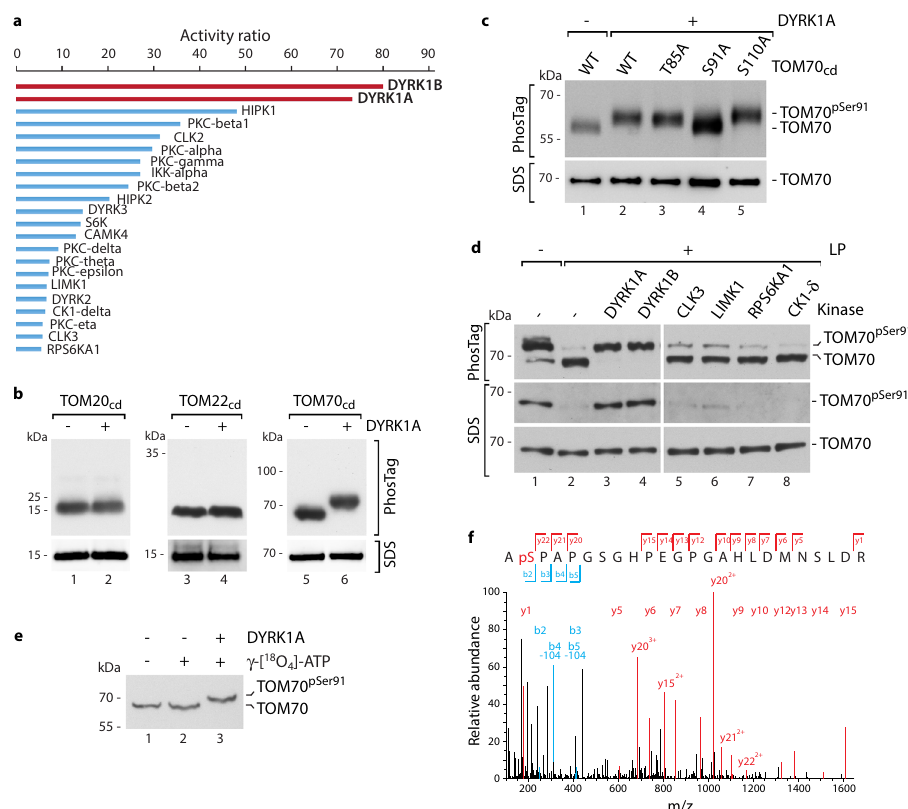
Fig. 1 Identi fi cation of DYRK1A as kinase of the mitochondrial import receptor TOM70. a Results of KinaseFinder assay (ProQinase TM ) for human TOM70 cd tested for 339 different protein kinases. Shown are activity ratios of 33 P-ATP-radiometric fi lter binding assays. b In vitro phosphorylation assay of soluble cytosolic domains (cd) of the human import receptors TOM70, TOM20, and TOM22. Proteins were incubated in the presence or absence of human DYRK1A. Samples were analyzed via Phos-tag electrophoresis, SDS-PAGE and immunoblotting using the respective TOM antibody (Supplementary Table 1). c In vitro kinase assay of indicated TOM70 cd variants in the absence or presence of DYRK1A. Samples were analyzed by Phos-tag gel electrophoresis (upper panel) or standard SDS-PAGE (lower panel) followed by immunoblotting using TOM70 antisera. d Analysis of isolated mitochondria from HEK293T cells incubated in the presence or absence of lambda phosphatase (LP). Where indicated samples were incubated with the respective kinase after LP treatment. Samples were analyzed by Phos-tag gels (upper panel) or standard SDS gels (middle and lower panel). Upper and lower panels show immunoblots stained with TOM70 antibody and middle panel was stained with TOM70 Ser91 phosphospeci fi c antibody. e Isolated mitochondria were incubated with γ -[ 18 O 4 ]-ATP and DYRK1A where indicated. Samples were analyzed via Phos-tag gels and immunoblotting using TOM70 antibody. f MS/MS spectrum from mitochondria incubated with γ -[ 18 O 4 ]-ATP shown in e localizing the DYRK1A-dependent phosphorylation of TOM70 to Ser91. Identi fi ed b- and y-ions are listed in blue and red, respectively. The b2-y22 ion pair localizes the phosphorylation unambiguously to Ser91. The amino acid sequence of the respective tryptic peptide TOM70 90 – 113 is indicated. Unprocessed immunoblots are reported in the Source Data